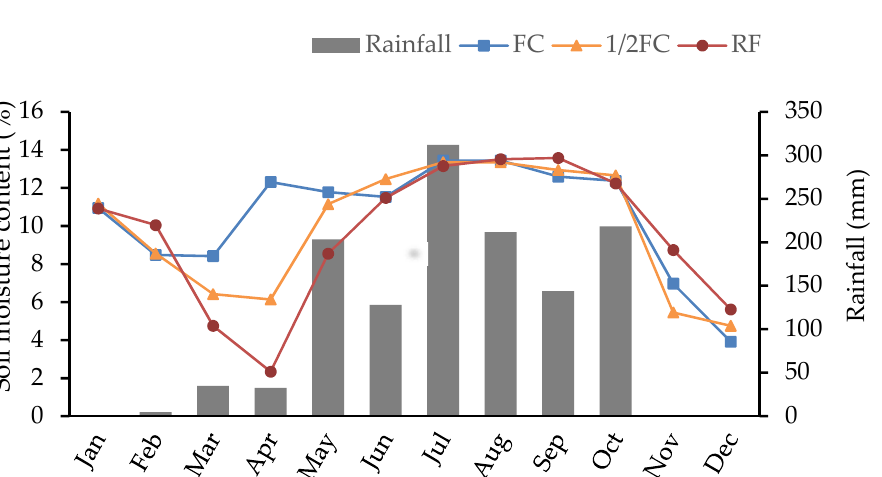
Figure 1. Soil moisture content at 15–45 cm below soil surface and rainfall between January and December 2017; FC = field capacity, ½FC = ½ field capacity and RF = rain fed.